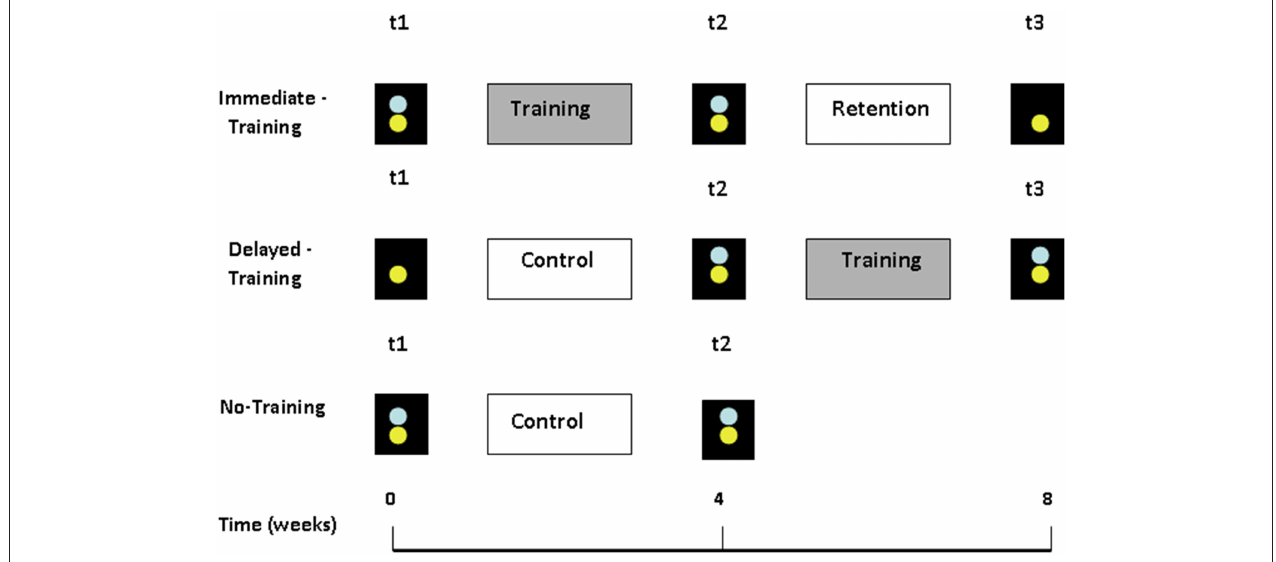
FIGURE 2 | Study design. Three testing sessions were conducted for the Immediate-Training and Delayed-Training groups (t1, t2, t3) and two testing sessions for the No-Training group (t1, t2). Immediate-training group underwent training between times t1 and t2 and Delayed-training group between t2 and t3. Blue (top) circles represent testing on trained tasks, yellow (bottom) circles represent testing on untrained